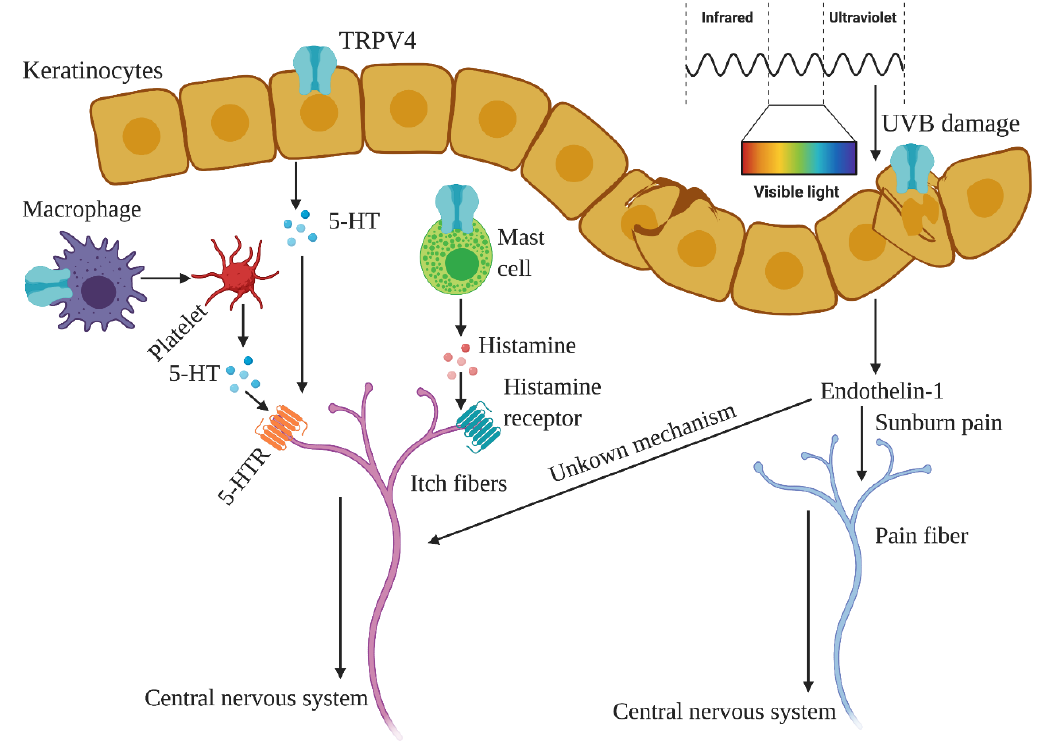
Figure 6. Three itch pathways associated to the function of TRPV4. When there are existing conditions such as dry skin, contact dermatitis, rosacea, etc., activation of TRPV4 in keratinocytes and in macrophages (that activate platelets) leads to the release of serotonin (5-HT) from these cells. 5-HT binds to its receptors in the itch fibers and this signal is transduced as itch in the central nervous system. Something similar occurs when TRPV4 channels in mast cells are overactivated or overexpressed, leading to the release of histamine that also activates receptors in itch fibers. It has also been proposed that UVB light damage, leads to the production of endothelin-1 that causes sunburn pain but could also cause post solar-burn itch through a mechanism not yet understood. 5-HTR, serotonin receptor. Created with Biorender.com.